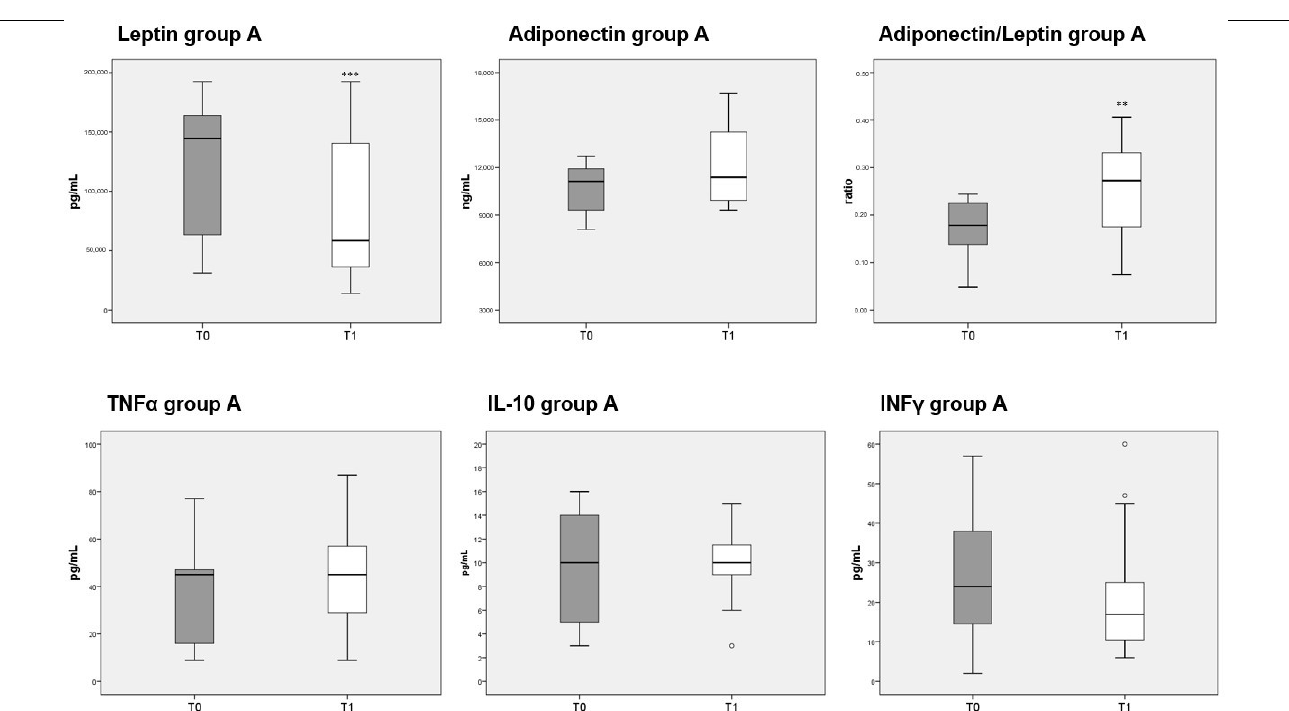
Figure 5. Box plots indicate the median and interquartile range of adipokines and cytokines measured in sera of patients belonging to group A. p -values derived from Wilcoxon matched-pairs signed rank test; ** p < 0.01, *** p < 0.001, T1 vs. T0.